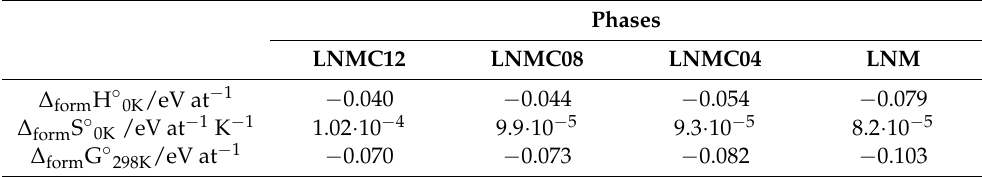
in Table 2: Gibbs free energy of formation of all LRLO are reported in the SI (Table S6) as a function of the temperature. Table 2. Thermodynamic data for the LNMC12, LNMC08, LNMC04, and LNM phases.